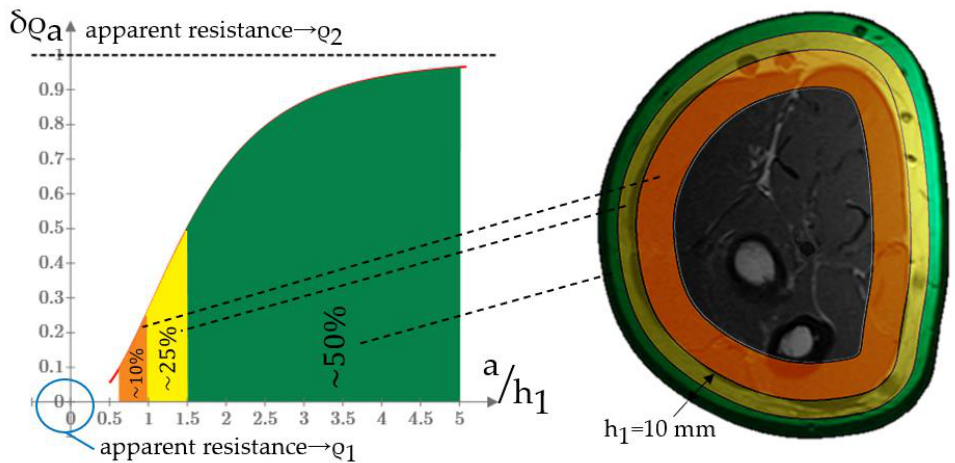
Figure 9. Relationship between the AR relative change and the ratio of the first layer thickness to the interelectrode distance ( left ) and its projection on the volunteer’s forearm MRI (girth 0.35 m) for ES with an interelectrode distance 0.01 m ( right ).